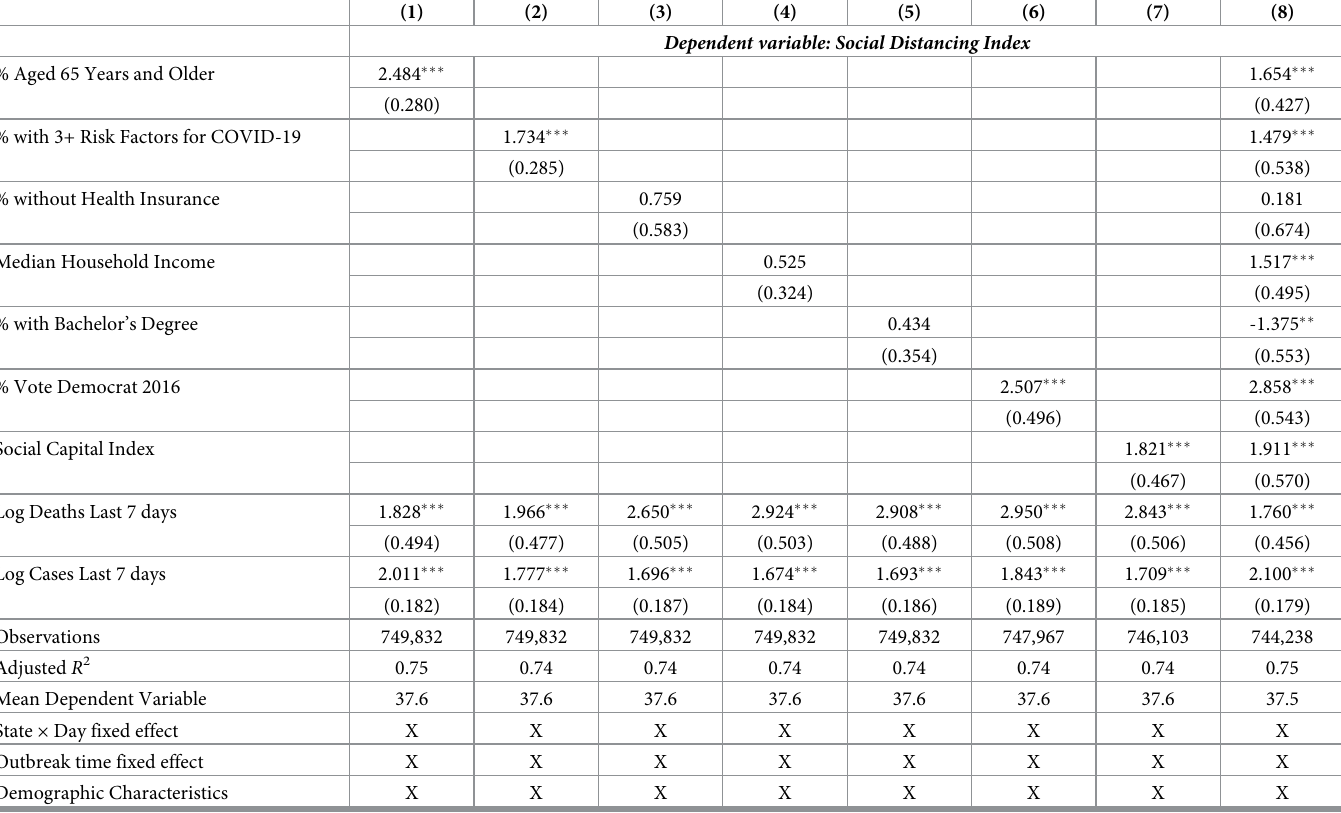
Table 1. Determinants of social